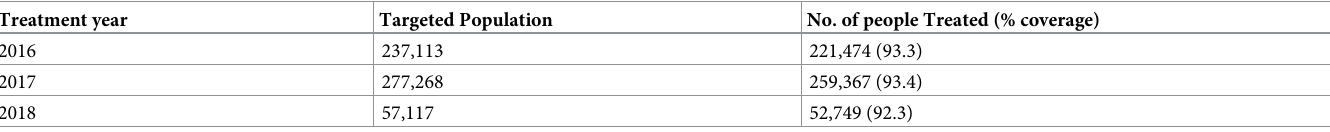
Table 3. Reported treatment coverage for MDA with Ivermectin and Albendazole in the past three years in Masasi District. Treatment year